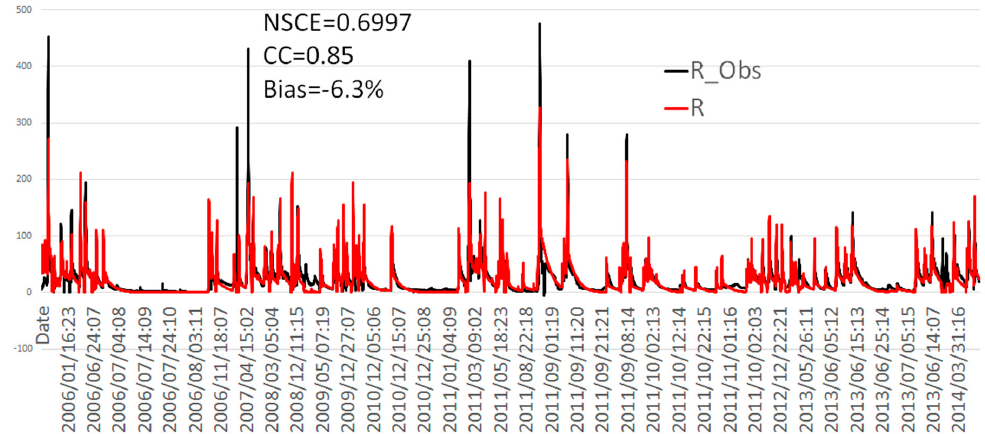
Figure 5. The Coupled Routing and Excess Storage–Soil–Vegetation–Atmosphere–Snow (CREST-SVAS) daily streamflow validation against observation for Naugatuck River Basin at the inlet of Thomaston Dam.